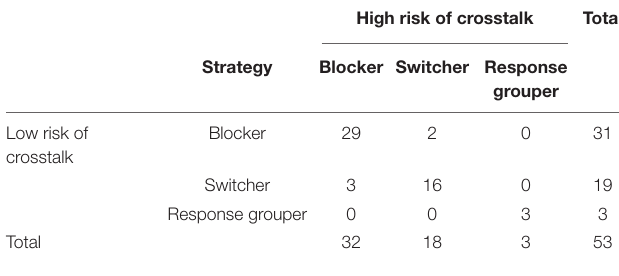
TABLE 1 | Contingency table of applied strategies of response organization in both crosstalk